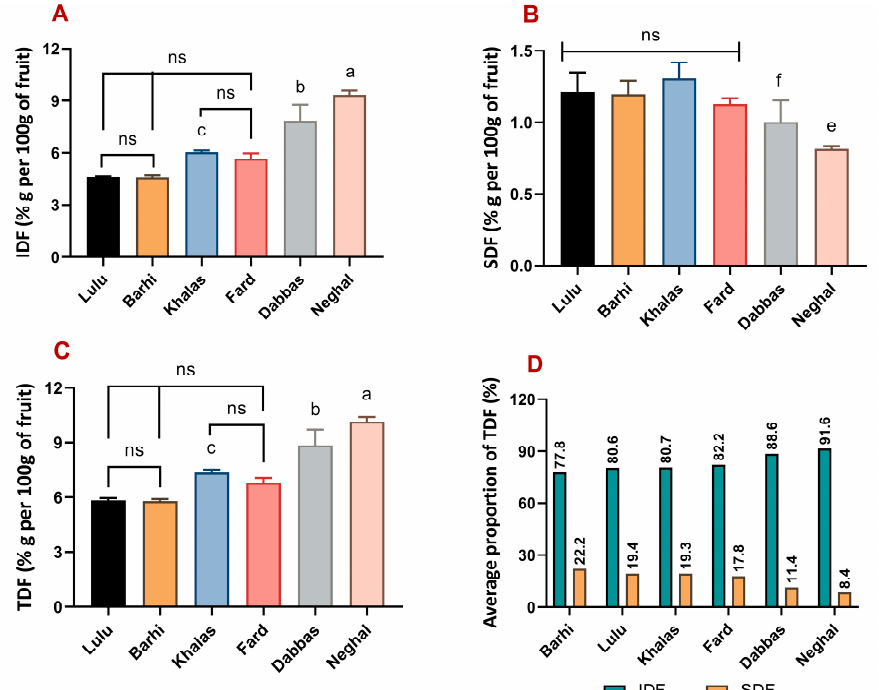
Figure 4. Comparison of dietary fibre content in six varieties of date fruits measured by the non- enzymatic method. ( A ) IDF data presented as mean ± s.d.; ( B ) SDF data presented as mean ± s.d.; ( C ) TDF data presented as mean ± s.d.; and ( D ) IDF and SDF data presented as an average percentage proportion of TDF. ANOVA, with multiple comparisons using the Tukey test, was used to compare the IDF, SDF, and TDF across the six date fruit varieties. Statistical significance was set at p -value ≤ 0.05. a—Neghal significant compared to all varieties; b—Dabbas significant compared to Fard, Khalas, Barhi and Lulu varieties; c—Khalas significant compared to Lulu and Barhi varieties; e—Neghal significant compared to all varieties except Dabbas; f—significant difference between Dabbas and Khalas varieties; ns—no significant difference.